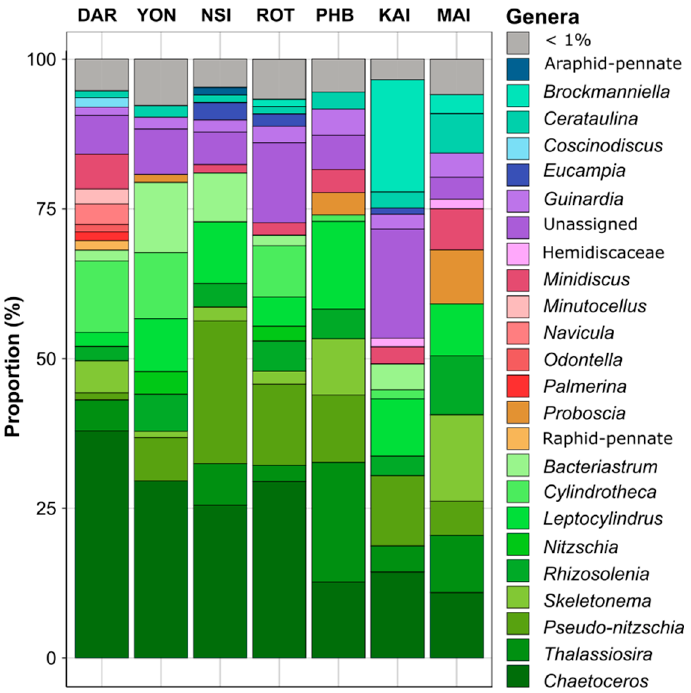
Figure 3. Marine Diatom Composition of Surface Waters (2 m) Collected from Seven National Reference Stations around Australia. Relative abundance (%) of the most abundant diatom genera (>1% threshold) across all sampling points between 2015–2019, using 18S rRNA gene as a phylogenetic marker (DAR: 28 samples, YON: 23 samples, NSI: 40 samples, ROT: 25 samples, PHB: 38 samples, KAI: 12 samples, MAI: 46 samples). Non-italic text corresponds to higher taxonomy levels. The full dataset is presented in Figure S1.